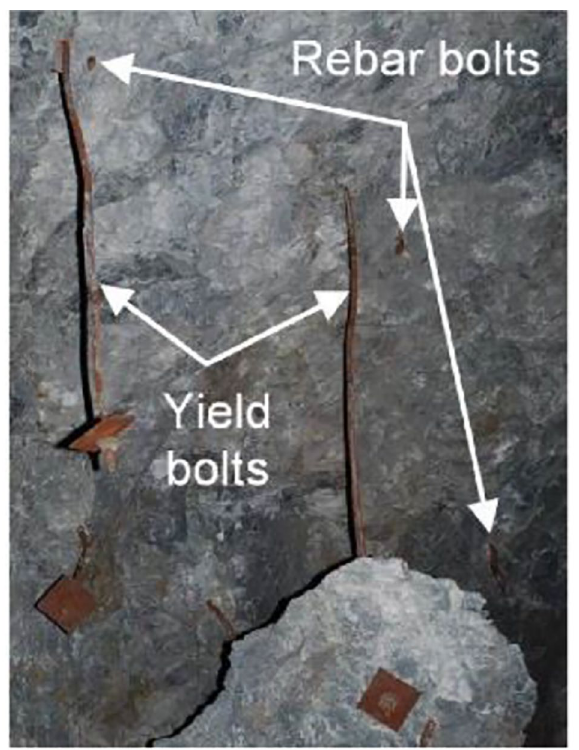
Fig. 22 Observed performance of fully resin-grouted rebar and yield- ing rockbolts in a rockburst (Li